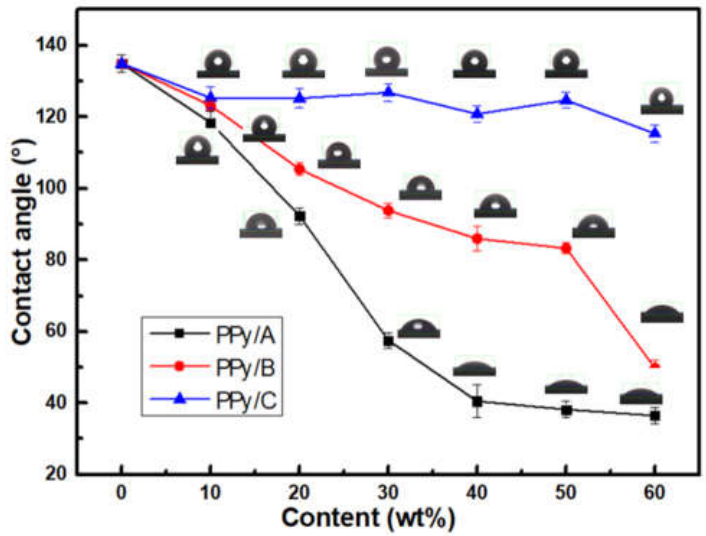
Figure 8. Contact angle of WPPy by different kinds of hydrophilic agents with different contents.